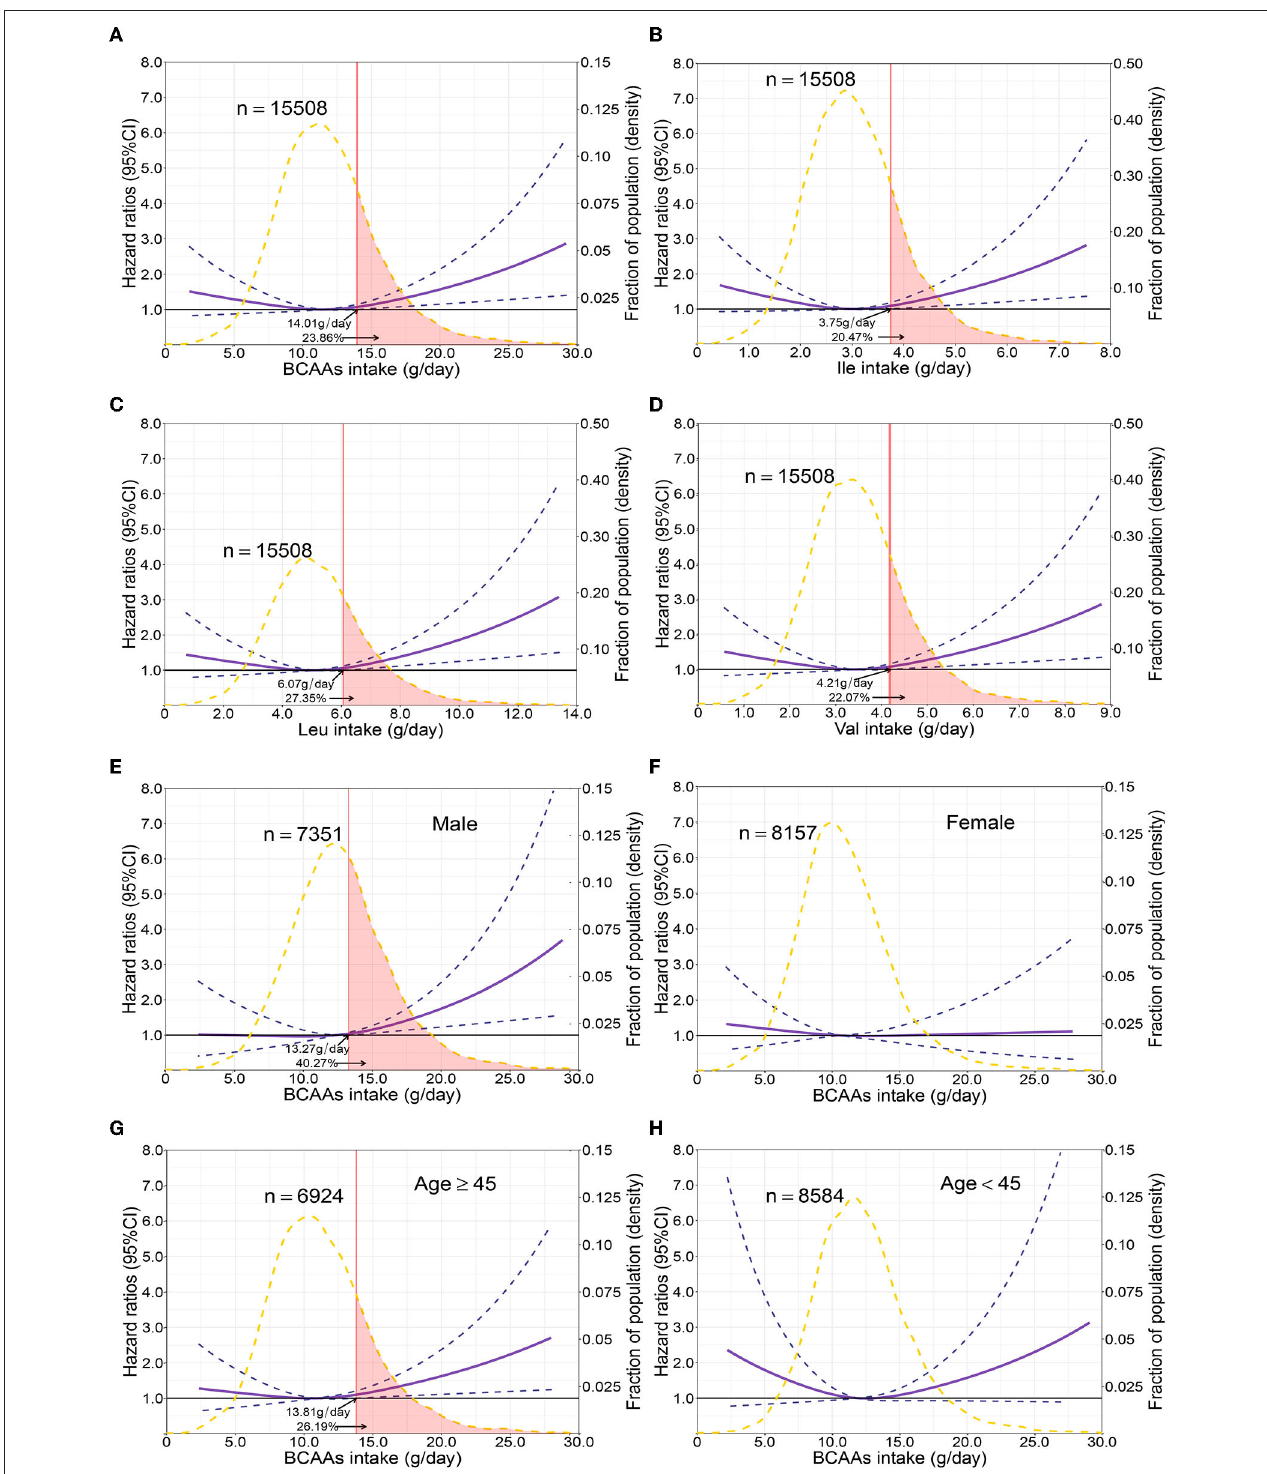
FIGURE 2 | Multivariable adjusted hazard ratios of incident type 2 diabetes according to levels of BCAAs consumption on a continuous scale in the overall population. Solid blue lines are multivariable adjusted hazard ratios, with dashed blues lines showing 95% confidence intervals derived from restricted cubic spline regressions with three knots. Reference lines for no association are indicated by solid bold lines at a hazard ratio of 1.0. Dashed yellow curves show fraction of population with different levels of BCAAs intake. Arrows indicate the lowest consumption of BCAAs and fraction of population with risk of T2D. Analyses were adjusted for age,